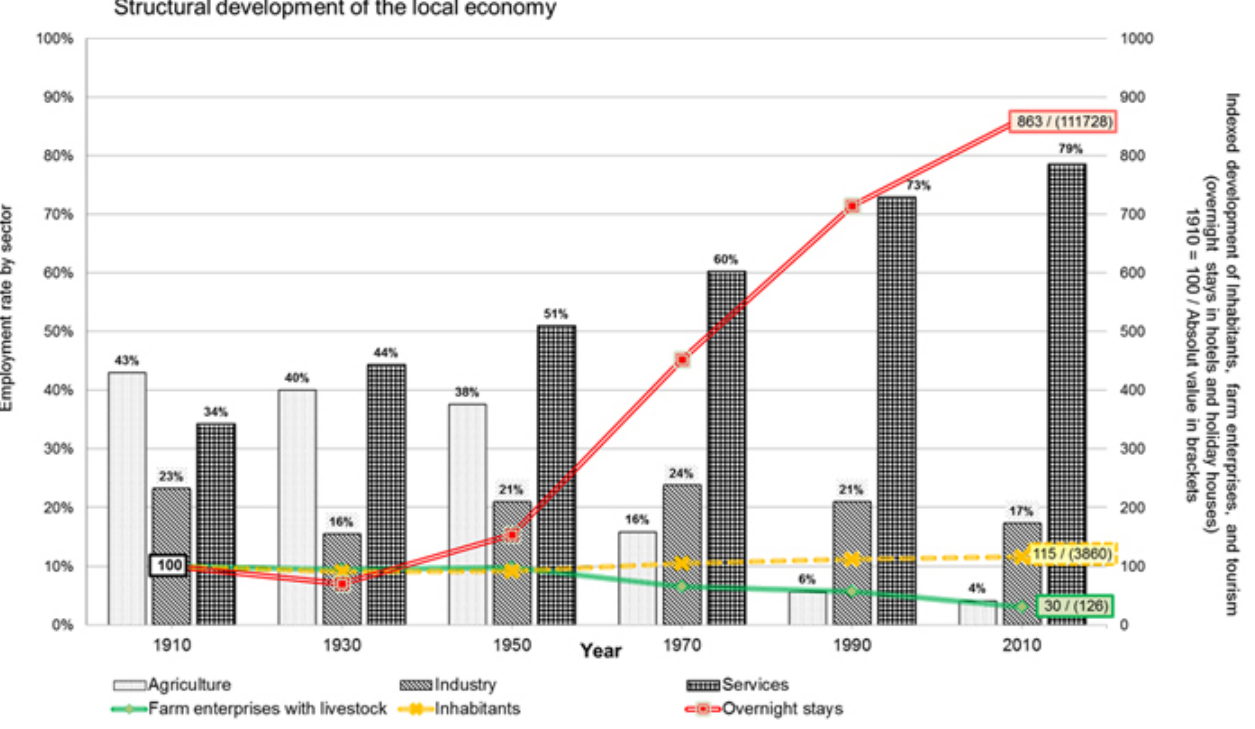
Fig. 2 . Number of overnight stays, farm enterprises and employees, and inhabitants in Grindelwald from 1910 to